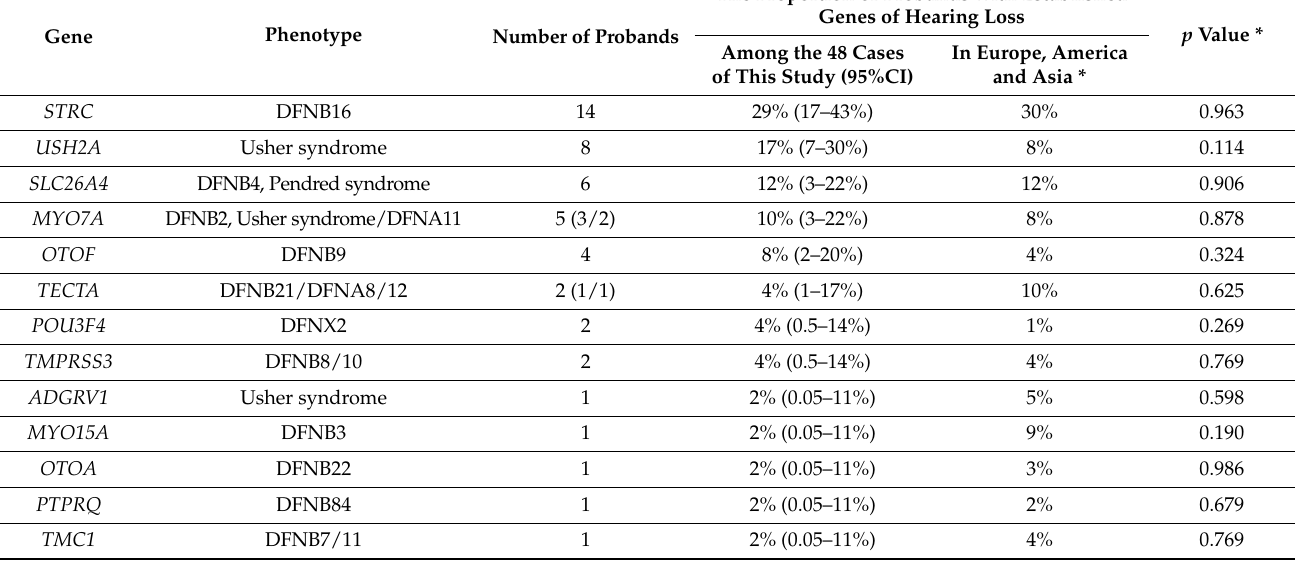
Table 2. The number of probands with NSHL with each of the identified genes of hearing loss among patients with an established molecular genetic diagnosis (n = 48). *—The comparison was made between the proportions in our cohort of Russian patients and the multi-ethnic sample of patients from Europe, America, and Asia from the study conducted by Sloan-Heggen et al. [10]. (95% CI)—confidence interval with the 95% confidence level.